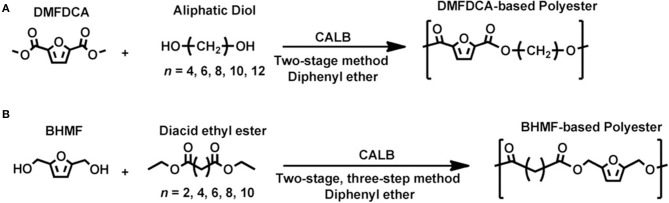
Lipase-catalyzed polycondensation of (A) DMFDC and aliphatic diols, and (B) BHMF and diacid ethyl esters developed by Maniar et al. (2019). Reproduced with permission from Maniar et al. (2019). Published by Wiley-VCH Verlag GmbH and KGaA.